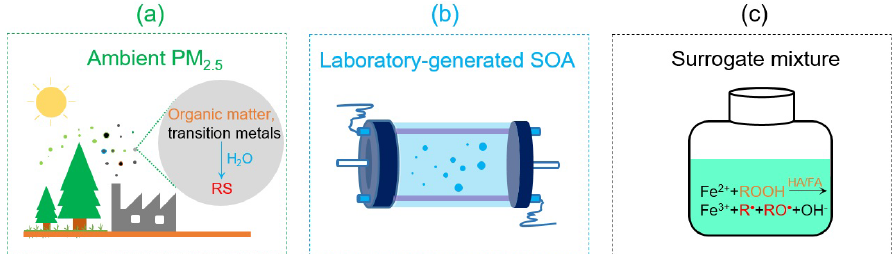
Figure 1. Schematic illustration of the approach used in this research and comparison of the aqueous-phase reactive species (RS) formed in aqueous extracts of ambient fine particulate matter (PM 2 . 5 ), laboratory-generated secondary organic aerosols (SOA), and surrogate mixtures. ROOH: organic hydroperoxide. HA: humic acid. FA: fulvic acid. R